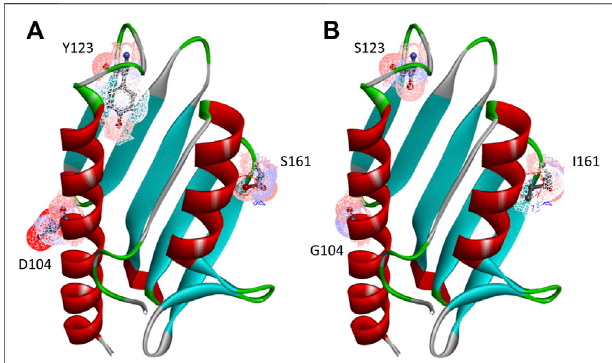
FIGURE 1 | Human FXN folded structure. The three point-mutations, D104G, Y123S, and S161I, which are the object of this investigation, are highlighted. (A) Wild-type, (B)